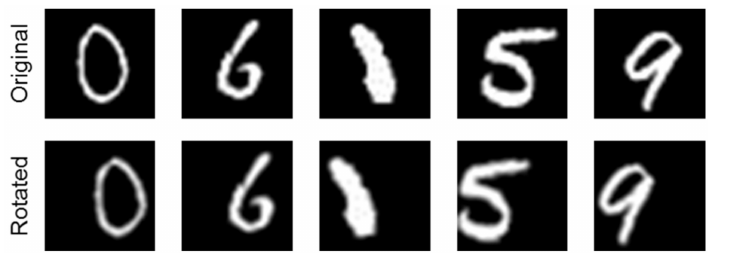
Figure 7. Example of the training images. The first row shows the original images, and the second row shows the images with random rotation.